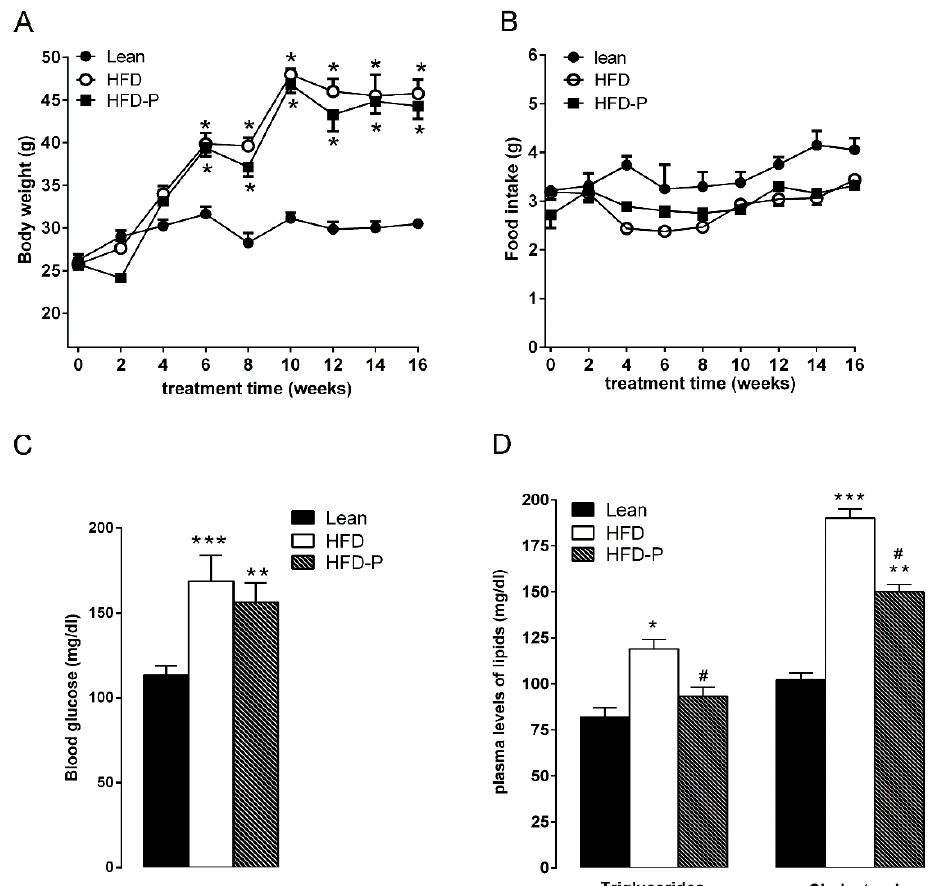
Figure 1. Effects of pistachio consumption on metabolic parameters. Pistachio consumption prevents high-fat diet (HFD)-induced hypertriglyceridemia and hypercholesterolemia. Body weight ( A ), food intake ( B ), fasting glycaemia ( C ), and plasma lipid levels ( D ) in lean, HFD, and HFD-P mice. Data are the means ± S.E.M. ( n = 8/group). Asterisk denotes significant difference compared with the lean group (* p < 0.05; ** p < 0.01; *** p < 0.001); hash denotes significant difference compared with the HFD group ( # p <